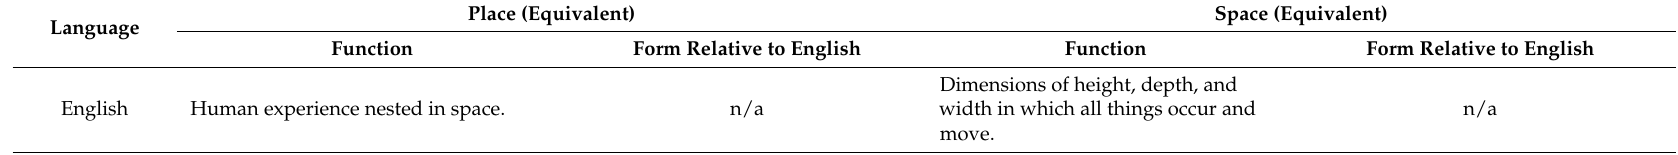
Table 1. Function and form of the terms place and space in the studied